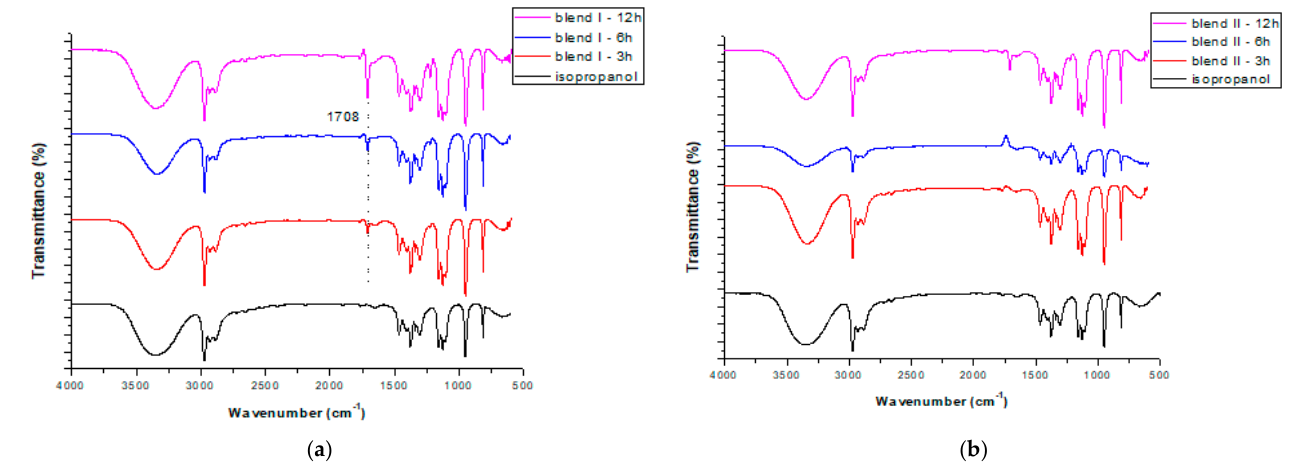
Figure 3. FTIR spectra of the pure isopropanol and isopropanol received after different extraction times, at 3, 6 and 12 h soxhlet extraction: in the case of blend I ( a ) and blend II ( b ).